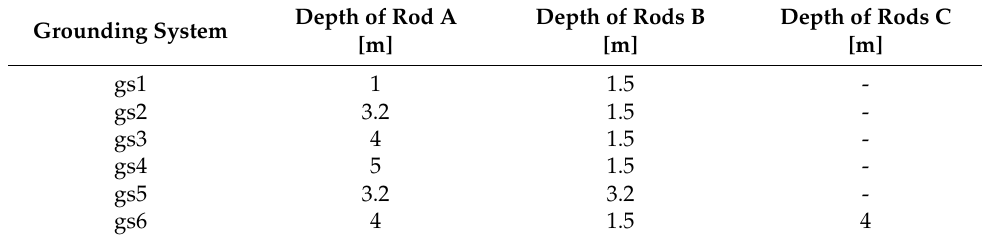
Table 2. Examined grounding systems (gs) characteristics (see Figure 9 for rods A, B, and C).